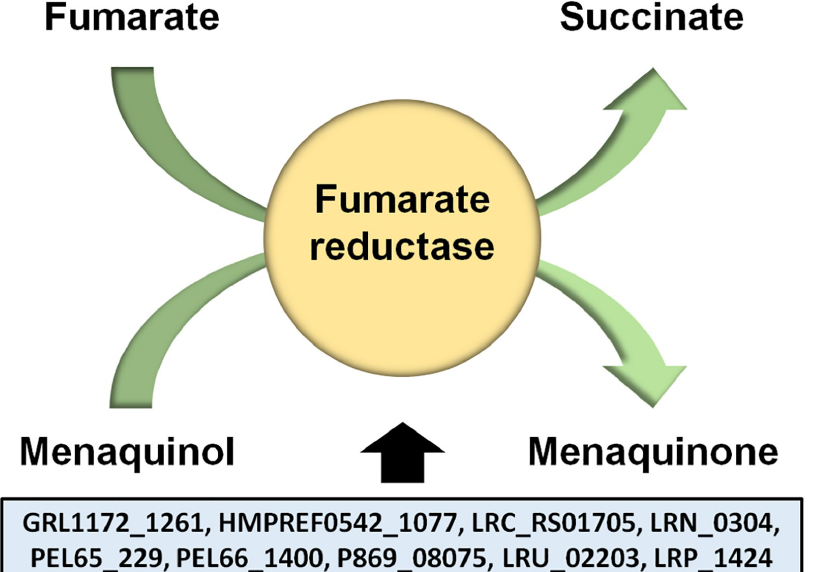
Fig 6. Schematic representation of the fumarate reductase-catalyzed reaction. Shownis the reaction catalyzed by fumarate reductase, where the reduction of fumarate to succinate is coupledwith the oxidationof menaquinol to menaquinone. Includedare the nine locus tags for the putative fumarate reductase genefound present in the L . ruminis core genome.